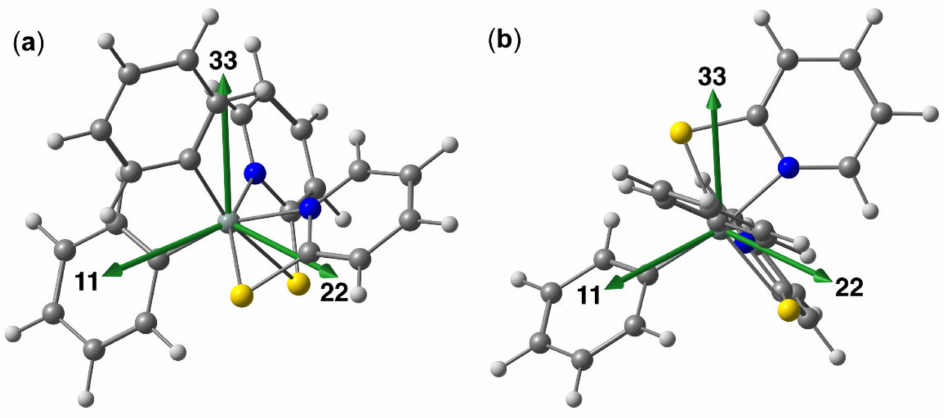
Figure 14. Graphical representation of the orientation of the 29 Si CSA tensor principal components in compounds 3b 1 ( a ) and 3b 2 ( b ) obtained at the PBE0 TZ2P level of theory. The respective orientation of the CSA tensors obtained at the PBE TZ2P level (not depicted) is very